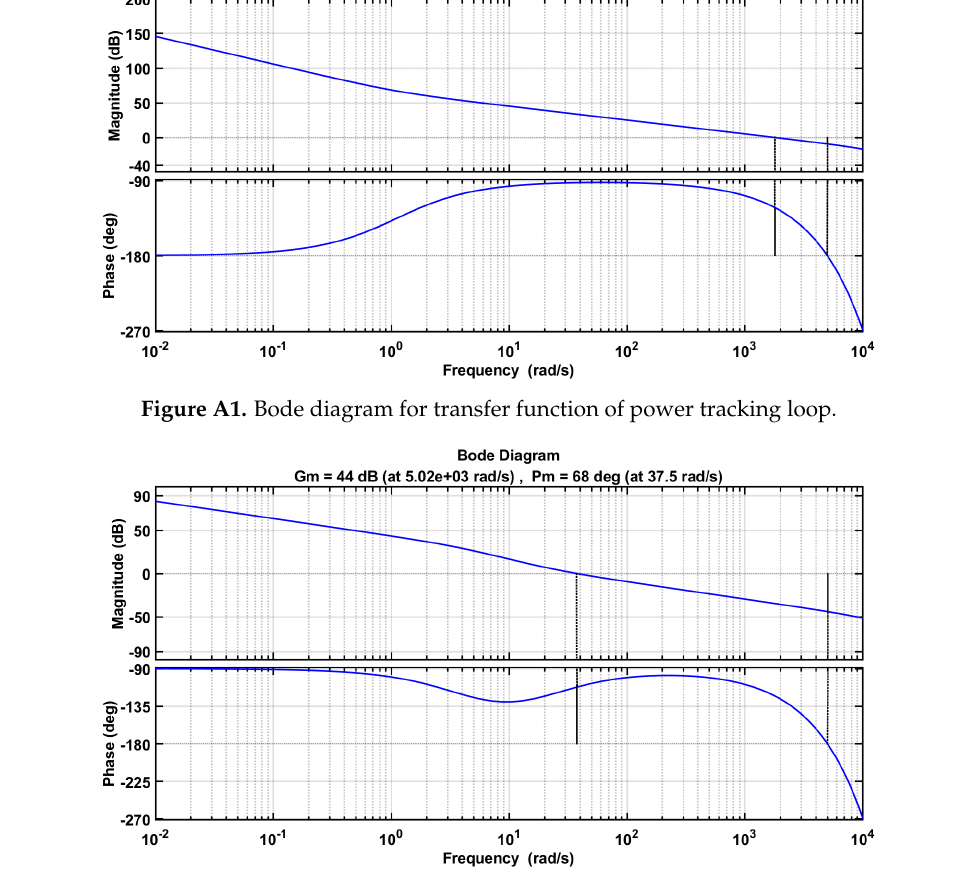
Figure A2. Bode diagram for transfer function of voltage regulation